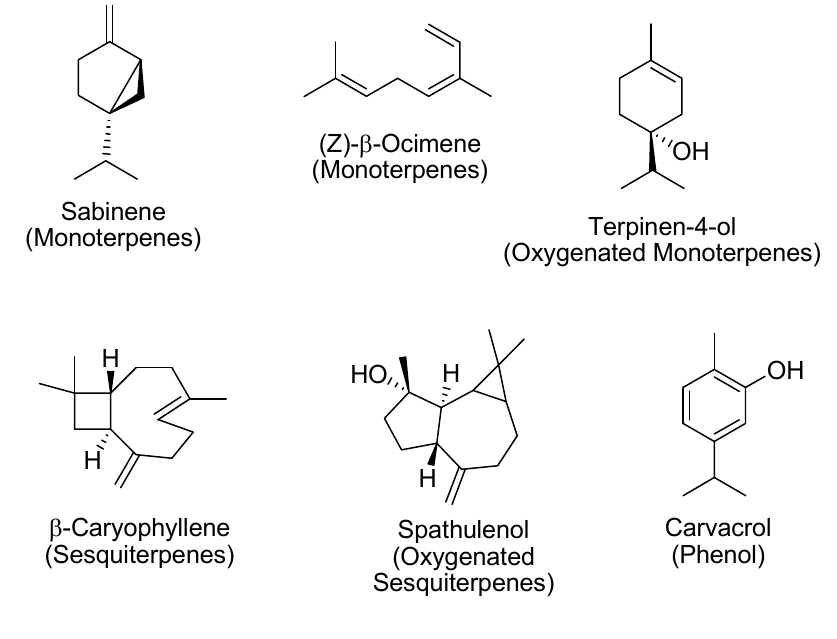
Figure 1. Chemical structures of the main constituents of Origanum vulgare essential